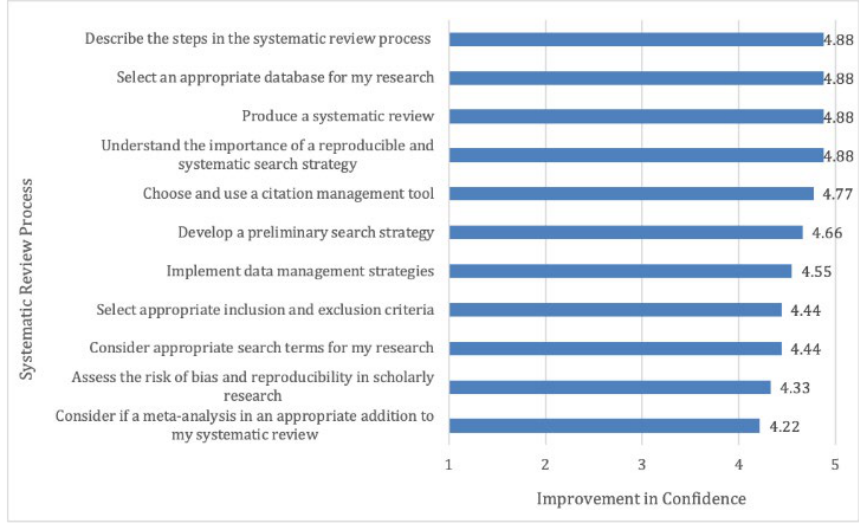
Figure 1 Post-assessment survey results: Student self-reported improved confidence at course